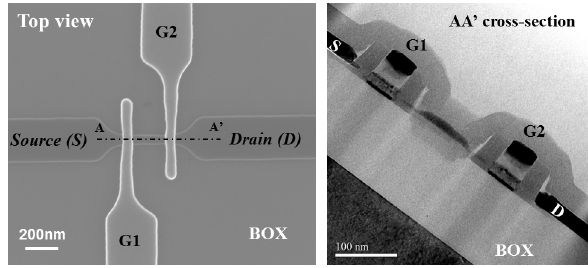
Figure 5. Two-gate device realized with deep-UV lithography. Left : Scanning electron micrograph of an actual device, with a gate pitch of 190nm; Right : Transmission electron micrograph of two-gate device realized with wide spacer